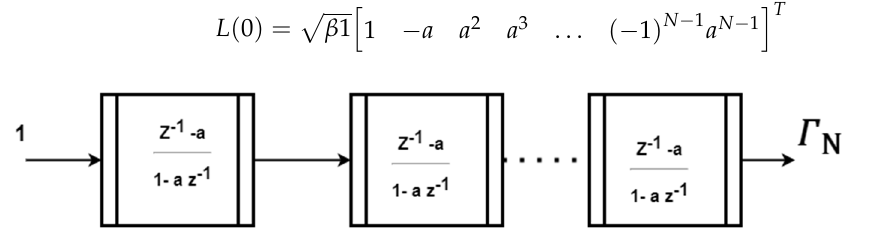
Figure 5. Discrete-time Laguerre network.